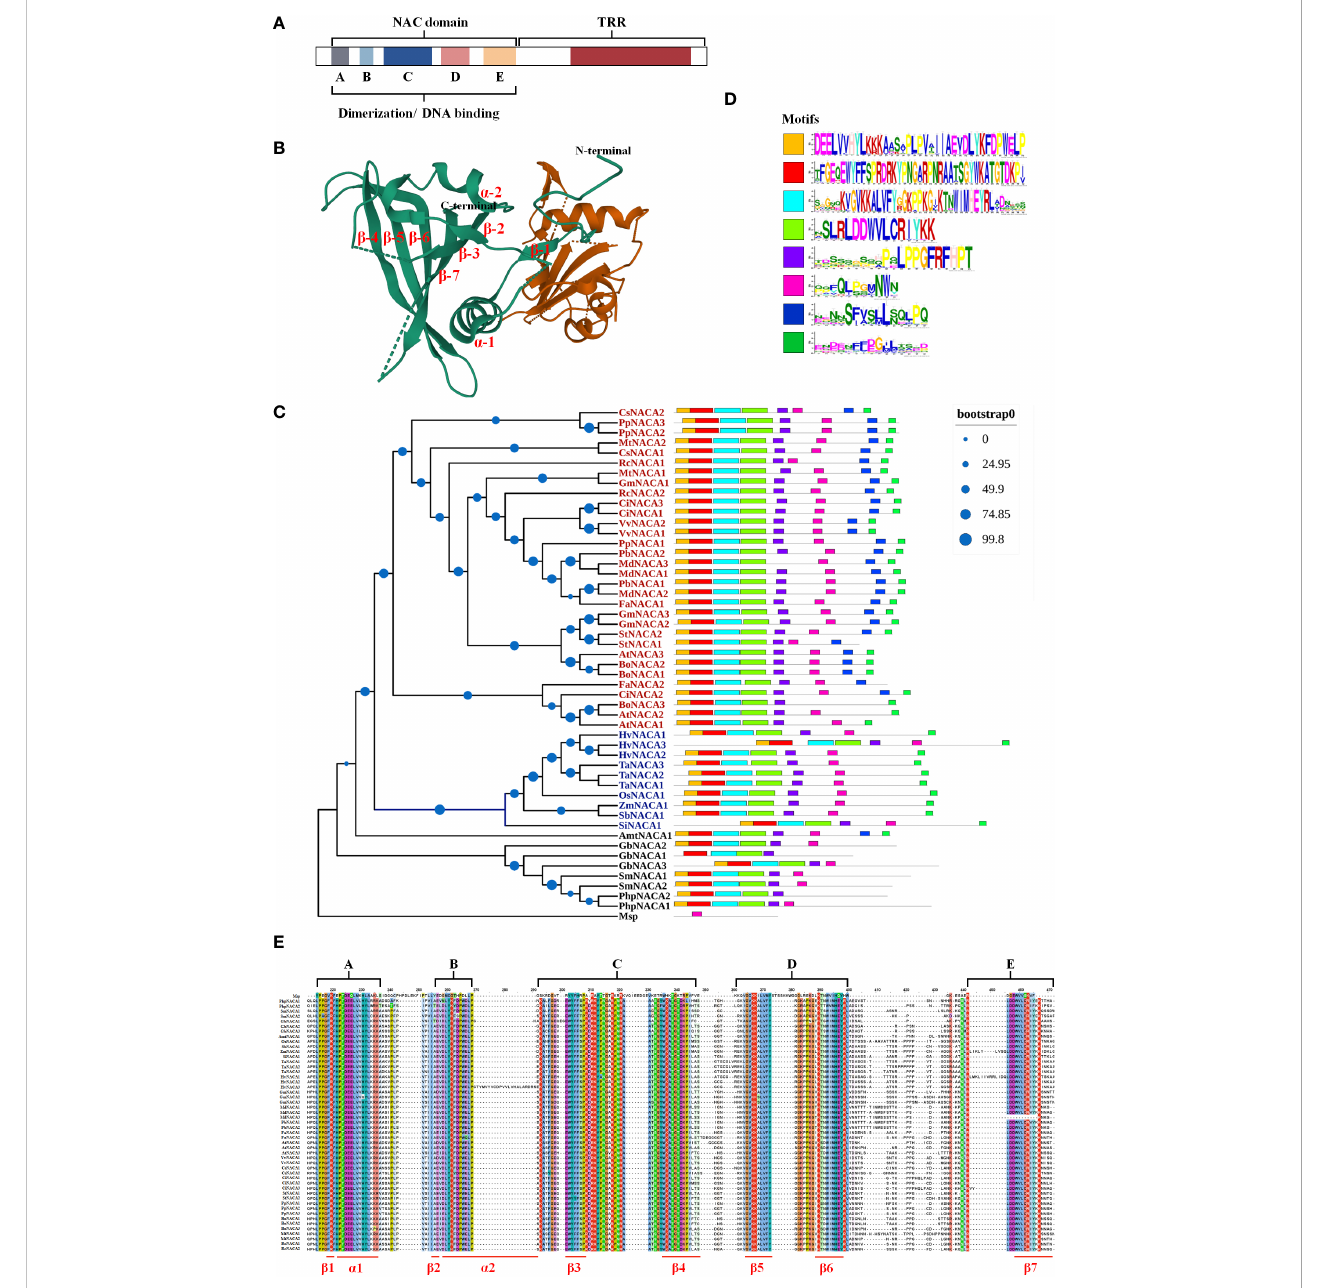
FIGURE 1 Basic traits of NAC (NAM, ATAF, and CUC) transcription factors (TFs). (A) Structure and function of NACs. (B) Three-dimensional structure of the Arabidopsis AtNAC019 protein homodimer. The AtNAC019 NAC domain crystal form IV is from the PDB database (PDB DOI: 10.2210/pdb4DUL/pdb). (C) Phylogenetic relationship of the NAC TFs. The homologous proteins of the strawberry NAC TF FaNACA2 (FaNAC035) (Mart ı ́ n-Pizarro et al., 2021) were found and veri fi ed in 24 species using BLAST and CDD tools, and a phylogenetic tree was constructed with reference to the evolutionary relationship of the NAC TF family in plants. The multiple sequence alignment, sequence pruning, model search, and phylogenetic tree construction were performed in Phylosuite_v1.2.2. The phylogenetic tree was obtained by applying the maximum likelihood method to a matrix of pairwise distances estimated using a JTT (Jones – Taylor – Thornton) model (bootstrap: ultrafast; no. of bootstraps: 10,000). Blue letters represent monocots and red letters represent dicots. Msp , Mougeotia sp.; Php , Physcomitrella patens ; Sm , Selaginella moellendorf fi i ; Gb , Ginkgo biloba ; Amt , Amborella trichopoda ; Si , Setaria italica ; Sb , Sorghum bicolor ; Zm , Zea mays ; Os , Oryza sativa ; Ta , Triticum aestivum ; Hv , Hordeum vulgare ; At , Arabidopsis thaliana ; Bo , Brassica oleracea ; Ci , Citrus sinensis ; Fa , Fragraria ananassa ; St , Solanum tuberosum ; Gm , Glycine max ; MD , Malus domestica ; Pb , Pyrus bretschneideri ; Pp , Prunus persica ; Vv , Vitis vinifera ; Rc , Ricinus communis ; Mt , Medicago truncatula ; Cs , Cucumis sativus . (D) The conserved motifs of all 51 sequences were queried online through the MEME website (https://meme-suite.org/meme/tools/meme). Motif1 corresponds to the A and B subdomains in the NAC domain, Motif2 contains the C subdomain, Motif3 corresponds to the D subdomain, Motif4 corresponds to the E domain, and Motif5 – Motif8 are the conserved motifs in the transcription regulatory region (TRR). (E) NAC domain consisting of fi ve subdomains: three highly conserved (A, C, and D) and two diverse (B and E)